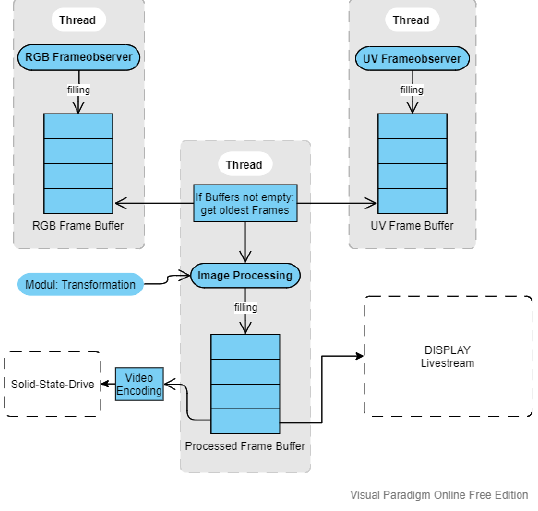
Figure 9. Flow diagram a software structure to achieve live